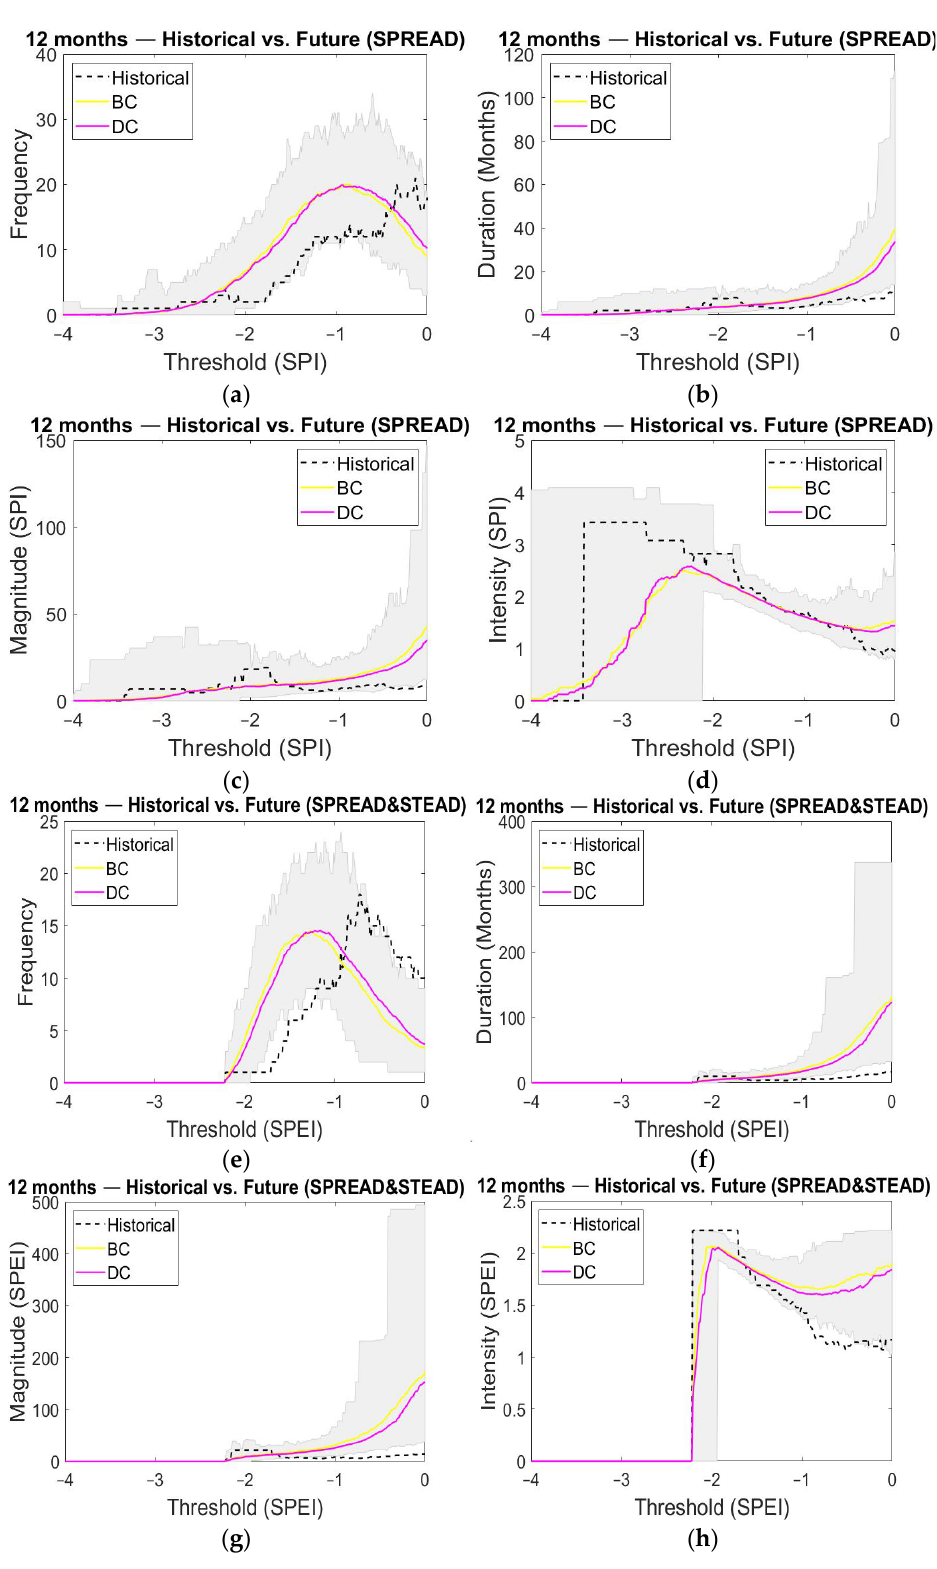
Figure A7. Historical and future meteorological drought ( a ) frequency; ( b ) mean duration; ( c ) mean magnitude; ( d ) mean intensity derived from SPI for the 12 months temporal-aggregation scale (SPREAD and STEAD database). Historical and future meteorological drought ( e ) frequency; ( f ) mean duration; ( g ) mean magnitude; ( h ) mean intensity derived from SPEI for the 12 months temporal- aggregation scale (SPREAD and STEAD